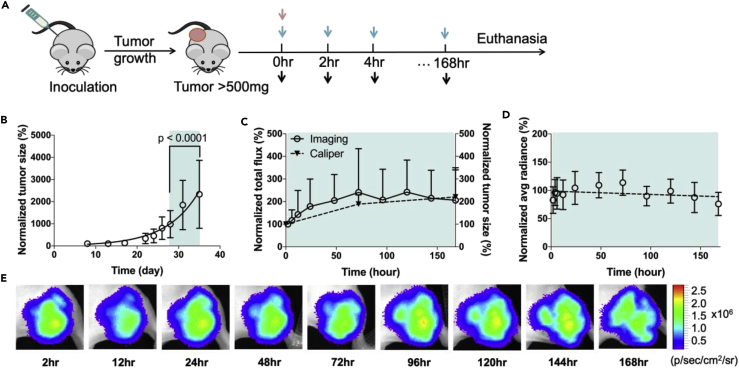
In Vivo Characterization of NanoLuc-EGFR Tumor Growth Kinetics(A) Schematic overview of the tumor inoculation, drug conjugate administration, IVIS bioluminescent imaging, and blood sample collection for animals administered DY605-antibody conjugates. Red arrow, tail vein injections of either DY605-cetuximab or DY605-IgG (control); blue arrows, tail vein injections of the NanoLuc substrate (furimazine); black arrows, imaging acquirements and blood sample collections.(B) Tumor growth curve from the day the tumor was inoculated (day 0) to day 35. The caliper-measured tumor sizes were normalized to the first-observed tumor volumes and fitted to the exponential growth curve. Normalized tumor volumes at days 28 and day 35 were compared using a two-tailed, unpaired Student's t test.(C) Tumor total photon flux at 500 ± 20 nm (NanoLuc emission) relative to caliper-measured tumor growth was normalized to the initial measurements at the first day of in vivo receptor occupancy (RO) study (day 28). The increase in total flux was tested by a null hypothesis, “the slope of linear regression of the dataset is significantly non-zero”. The null hypothesis was not rejected by a p value of 0.01. The trends of the normalized tumor-NanoLuc total photon flux and the normalized tumor volumes, measured by calipers, were compared using a null hypothesis, “the slopes of the linear regressions are same for all datasets.” The null hypothesis was rejected by a p value of 0.736.(D) The NanoLuc-EGFR tumor densities were estimated using normalized tumor average radiances. The trend of average radiances was evaluated by testing the null hypothesis that “the slope of linear regression of the dataset is significantly non-zero,” which was rejected by a p value of 0.34. During the in vivo RO detection phase of the study, NanoLuc-EGFR densities did not change significantly. For panels (B–D), the RO detection phase of this in vivo study is highlighted by the green area (day 28 to day 35, 0–168 h post dosing). All the animals (n = 19) were included in the tumor size, tumor area total flux, and average radiance analyses. Each data point represents the mean value of the tumor size, tumor area total flux, and average radiance of 19 individuals at the same time point. Data are presented as mean ± SD.(E) Representative images of the tumor NanoLuc-EGFR densities (radiance intensity) measured throughout the in vivo RO phase of the study.